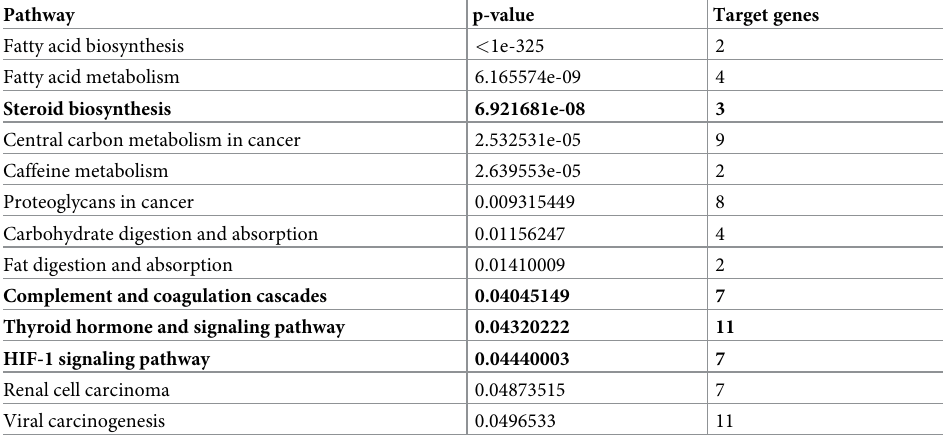
Table 2. Statistically significant union pathways refer to the miRNAs with an increased expression on day 1.